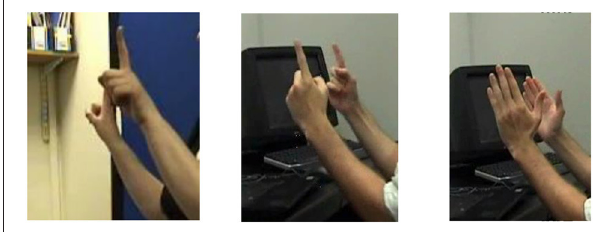
FIGURE 2 | Over-differentiation in a BSL-learner’s representation of two people standing next to one another. The native signer, in the photograph on the left, uses two upright index fingers to represent two people. The learner of sign also uses two index fingers in the photograph in the middle, but then changes to two flat hands in the photograph on the